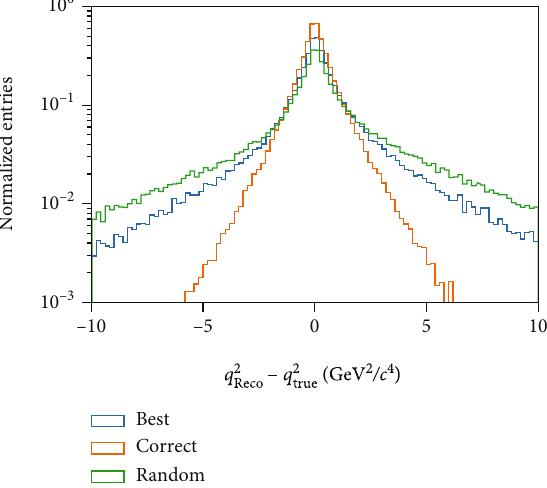
Figure 4: The performance of di ff erent regressors with “ label C ” variables. Δ P = P GB regressor. “ Regressor C ” : MLP regressor.